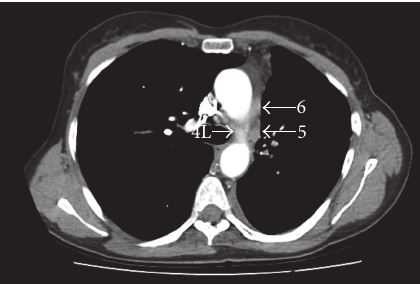
Figure 5: Computed tomography chest scan at the level of IASLC stations 4L, 5, and 6 (white